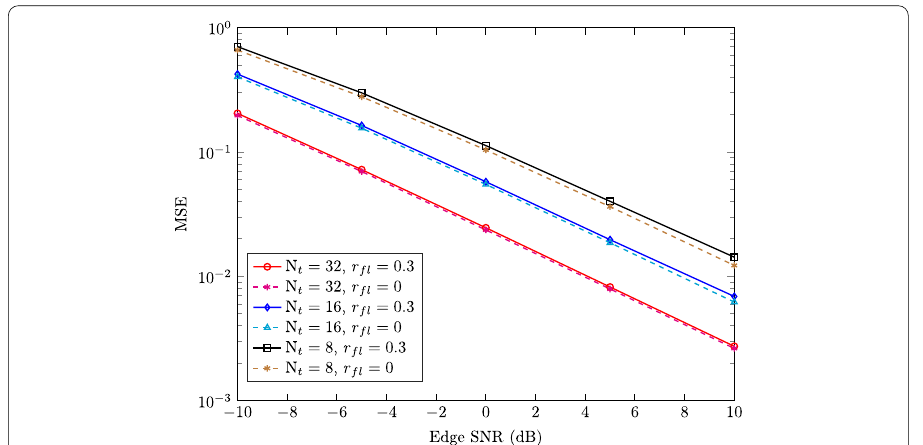
Fig. 13 MSE performance of the proposed precoder as function of edge SNR in various number of transmit antennas in SFB-CBH ( r fl = r bl = 0.3 ) and FFB-FBH configurations. The channel is time-variant with (cid:31) t = 1 ms , v = 5 km / h and N r = 2